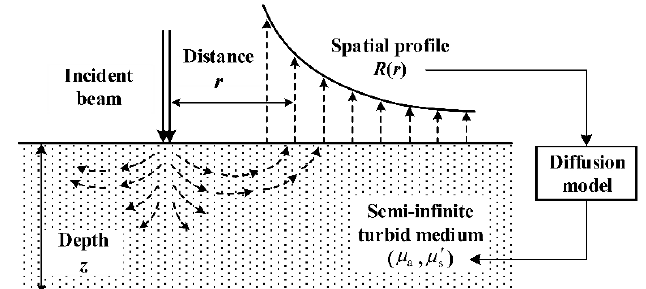
Figure 19. Principle of the spatially-resolved technique for optical property measurement.